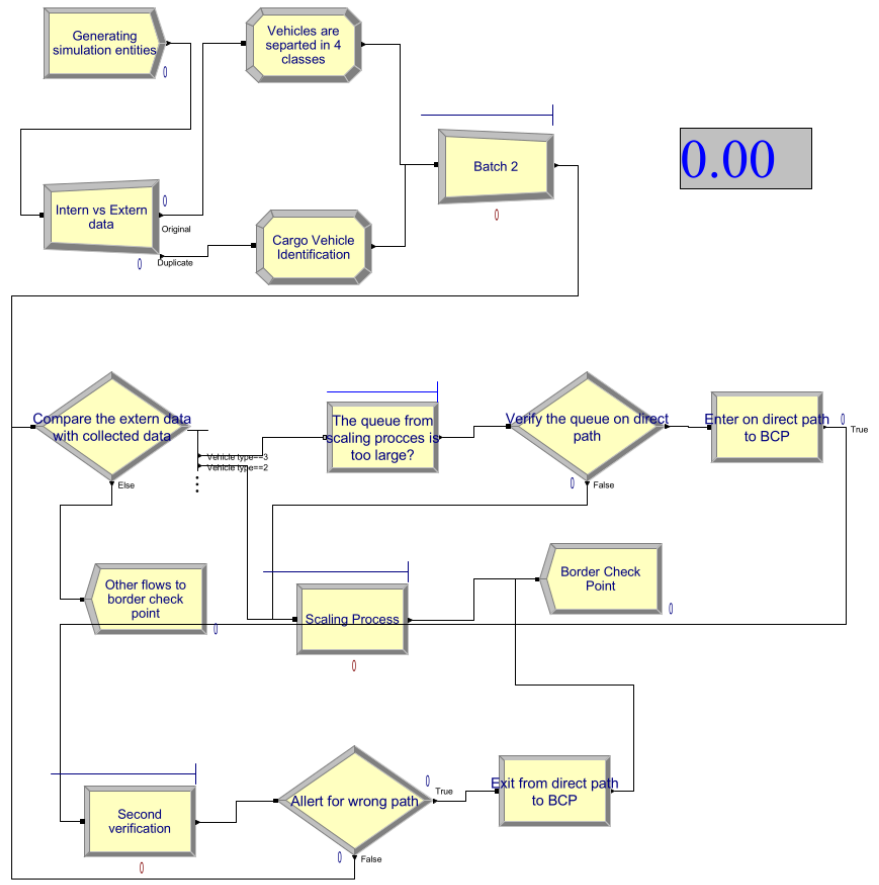
Figure 8. The simulation model for the case with Smart Hub equipment implemented.